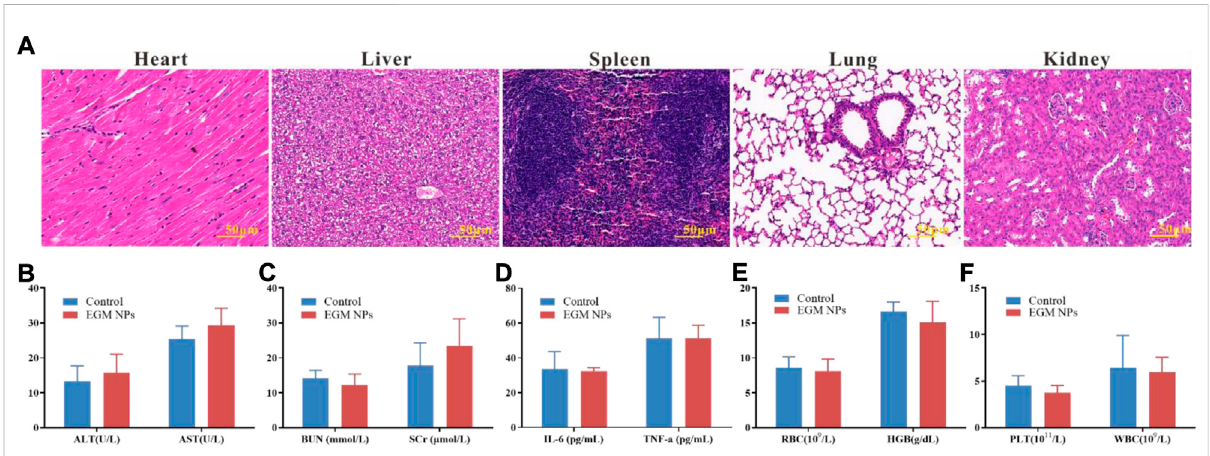
FIGURE 7 Biocompatibility assessment of EGM NPs. (A) HE staining of major organs (heart, liver, spleen, lung, kidney) in normal mice 24 h after intravenously injection with EGM NPs. (B – D) Serum levels of liver function indicators (B) , kidney function indicators (C) and in fl ammatory factors (D)